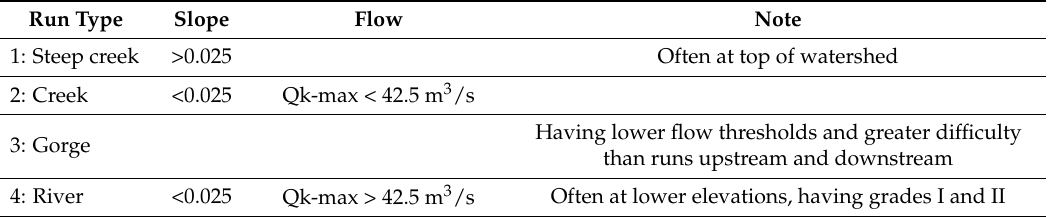
Table 2. Run types and their characteristics according to Ligare et al. [1]. Qk-max is the maximum flow for WW